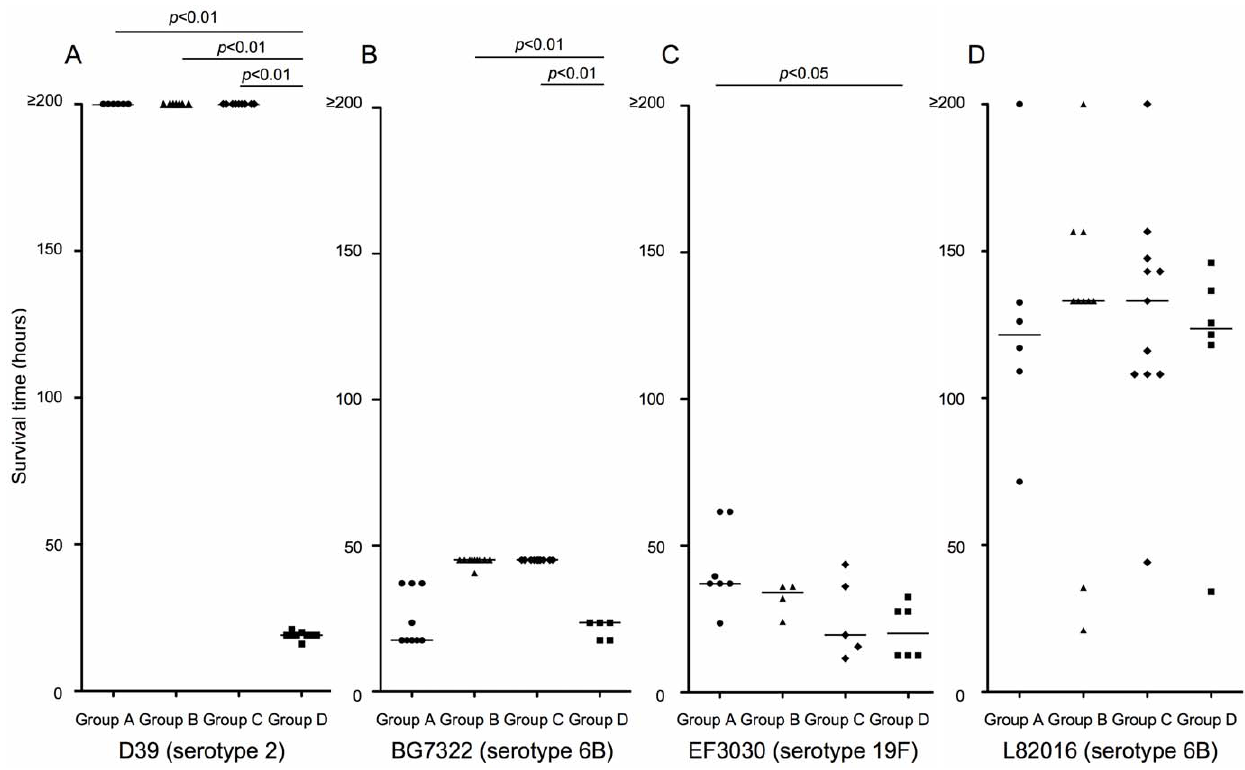
Figure 8. Cross-protection against fatal infections with pneumococcal strains expressing family 1 PspA. As in the prior studies the mother mice were immunized with a rPspA2 of strain TIGR4. Offspring at 10-days of age were intraperitoneally challenged with D39 (PspA1, serotype 2; 50 CFUs/mouse), BG7322 (PspA1, serotype 6B; 20 CFUs/mouse), EF3030 (PspA1, serotype 19F; 5 6 10 6 CFUs/mouse), and L82016 (PspA1 serotype 6B, 5 6 10 6 CFUs/mouse) in 100 m l with anesthesia. After challenge, the mice were monitored for 10 days to determine the day of death. Group A mice were offspring delivered from PspA-immunized mothers and breast-fed by the same mothers (n=6 for D39, n=10 for BG7322, n=7 for EF3030, n=6 for L82016). Group B mice were offspring from sham-immunized mothers and breast-fed by a PspA-immunized mothers (n=7 for D39, n=11 for BG7322, n=4 for EF3030, n=10 for L82016). Group C were offspring from PspA-immunized mothers and breast-fed by sham-immunized mothers (n=9 for D39, n=11 for BG7322, n=5 for EF3030, n=11 for L82016). Group D mice were offspring from sham-immunized mothers and breast-fed by the same mothers (n=9 for D39, n=5 for BG7322, n=6 for EF3030, n=6 for L82016). p , 0.05 and p , 0.01 for the indicated comparisons with offspring in Group D by Kruskal-Wallis test with Dunn’s multiple comparison test are shown.